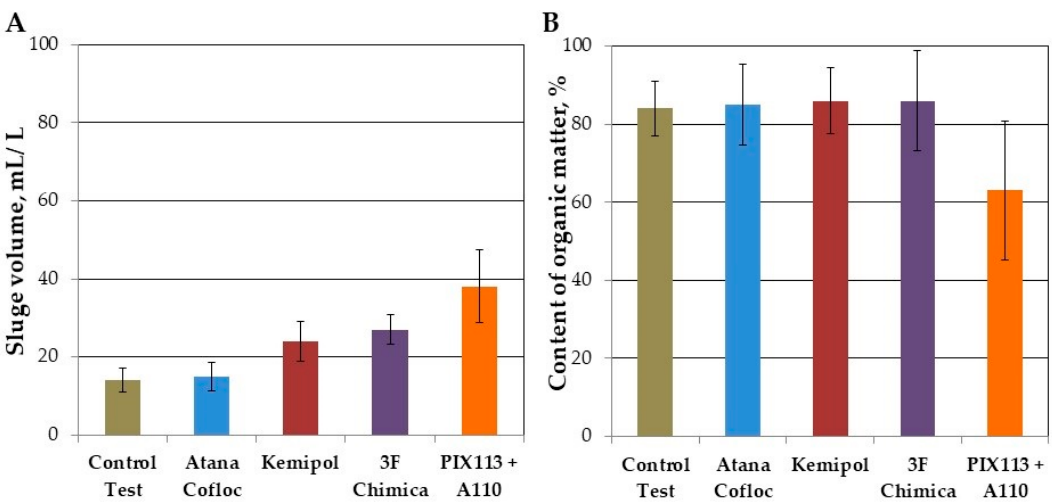
Figure 5. Sludge separated in the chemically enhanced primary treatment (CEPT) process ( A ) volume after 2-h sedimentation, ( B ) organic matter content.